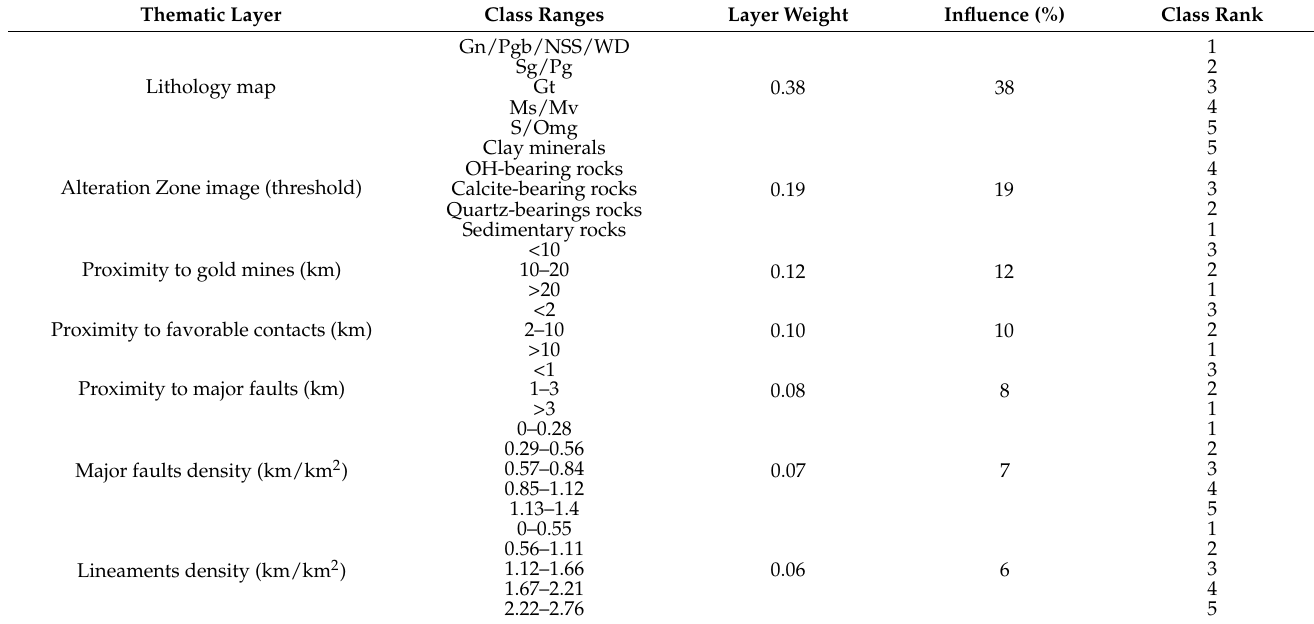
Table 3. Weights assigned for different gold mineralization parameters in the study area.